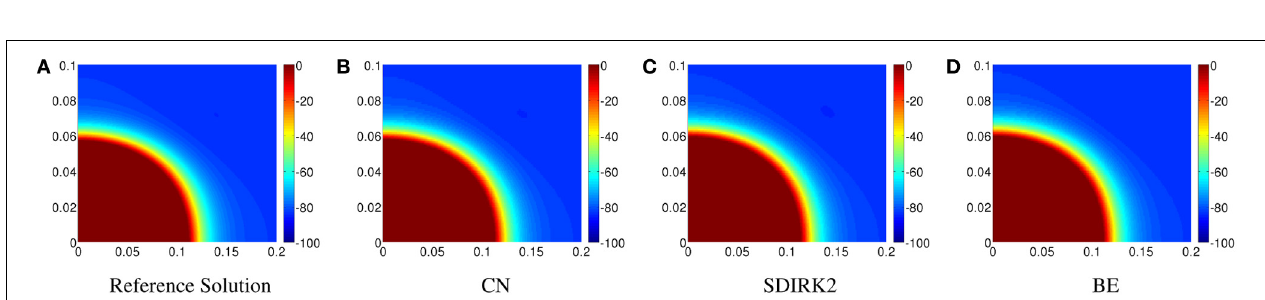
FIGURE 5 | Plots of the transmembrane potential at the spatial point (0.004, 0.032) and t ∈ [0, 2]ms for Scenario II: (A) reference solution, (B) CN solution, (C) SDIRK2 solution, and (D) BE solution.